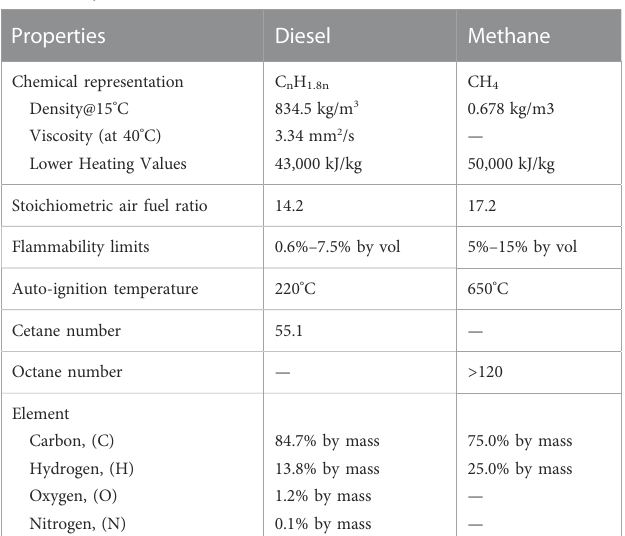
TABLE 1 Physiochemical characteristics of Diesel and Methane. TABLE 2 Speci fi cations of the test